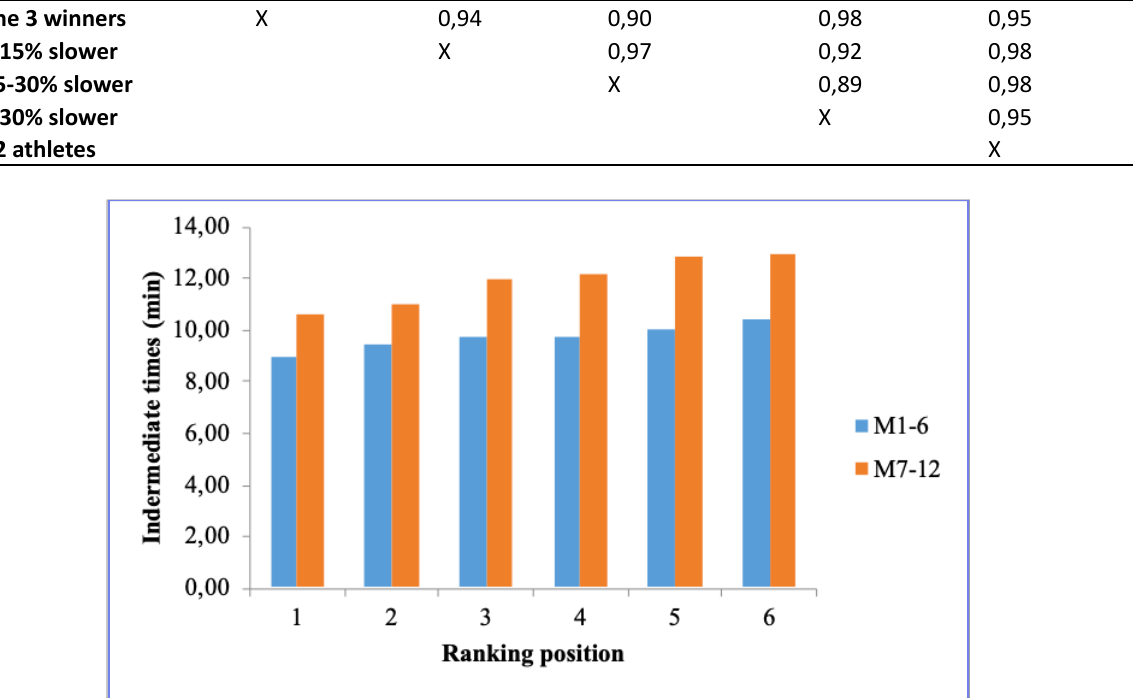
Figure 7 . Comparison of the mean values (M) of the performance between the group of the first 6 athletes M1-6 (9.69 ± 0.48) and the last 6 athletes M7-12 (11.92 ± 0.97), with correlation r = 0.97 where the t-test showed the difference in performance between the two groups of athletes t = 6.25>tc = 2,179 with bilateral control (p